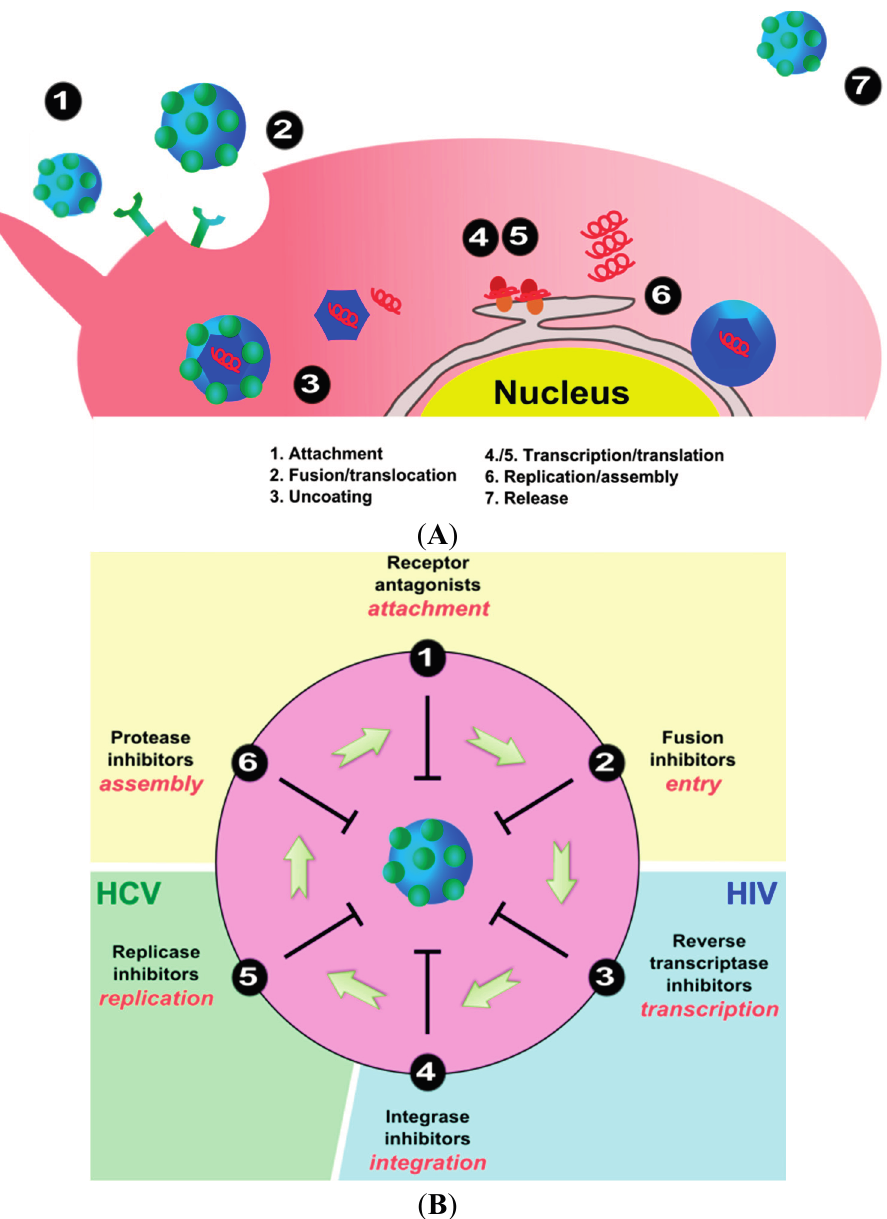
Figure 2. ( A ) Simplified schematic representation of viral replication cycle. Abbreviation ER: endoplasmic reticulum; ( B ) Potential points of attack of antiviral nanostructures in the viral replication